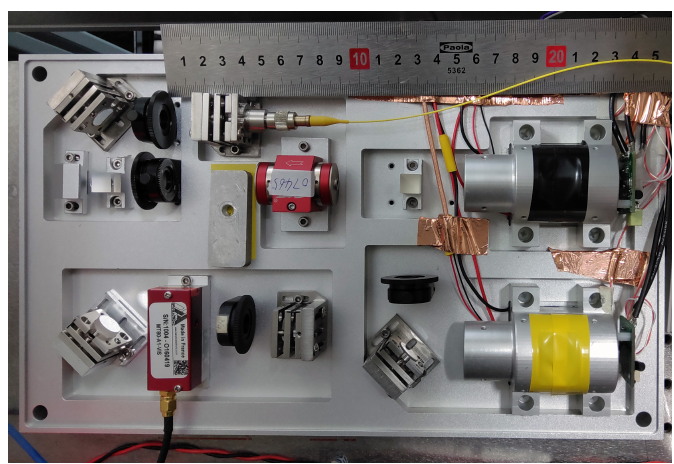
Figure 4. Photograph of the ECDL, which has been applied to space narrow-linewidth-laser demonstration systems.